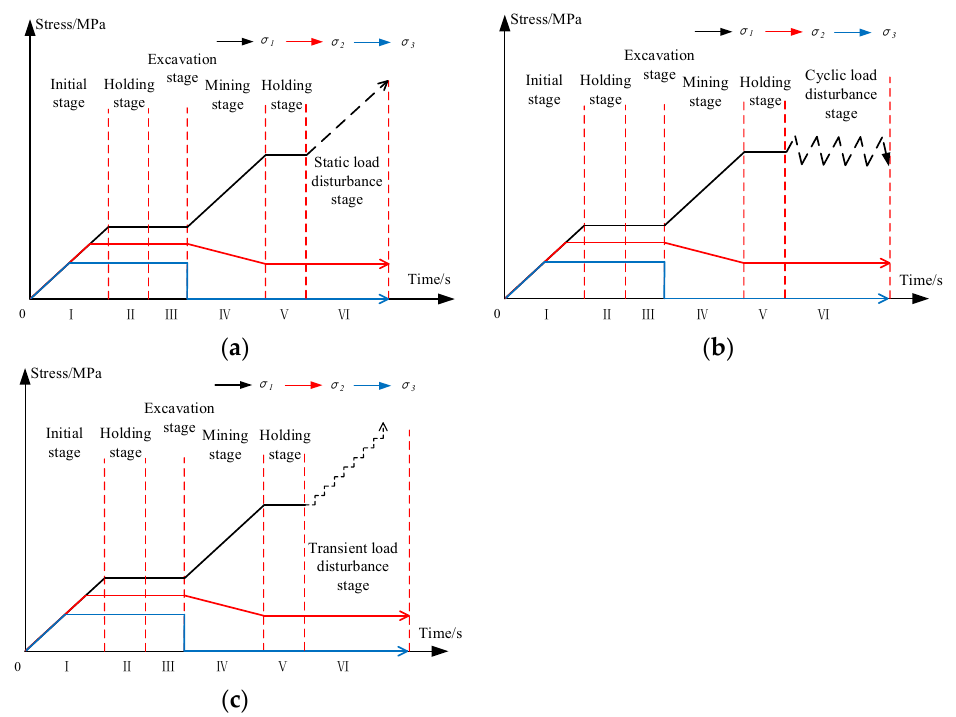
Figure 5. Stress path of different disturbance stress: ( a ) static load; ( b ) cyclic load; ( c ) transient load.